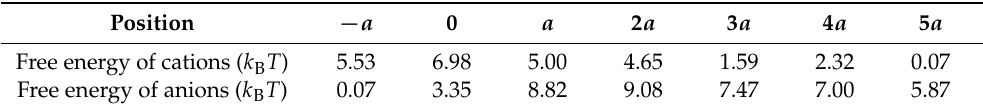
Table 1. Free energy values of ions relative to free solution. The positions in the pore are indicated in Figure 1. Position − a 0 a 2 a 3 a 4 a 5 a Free energy of cations ( k B T ) 5.53 6.98 Free energy of anions ( k B T